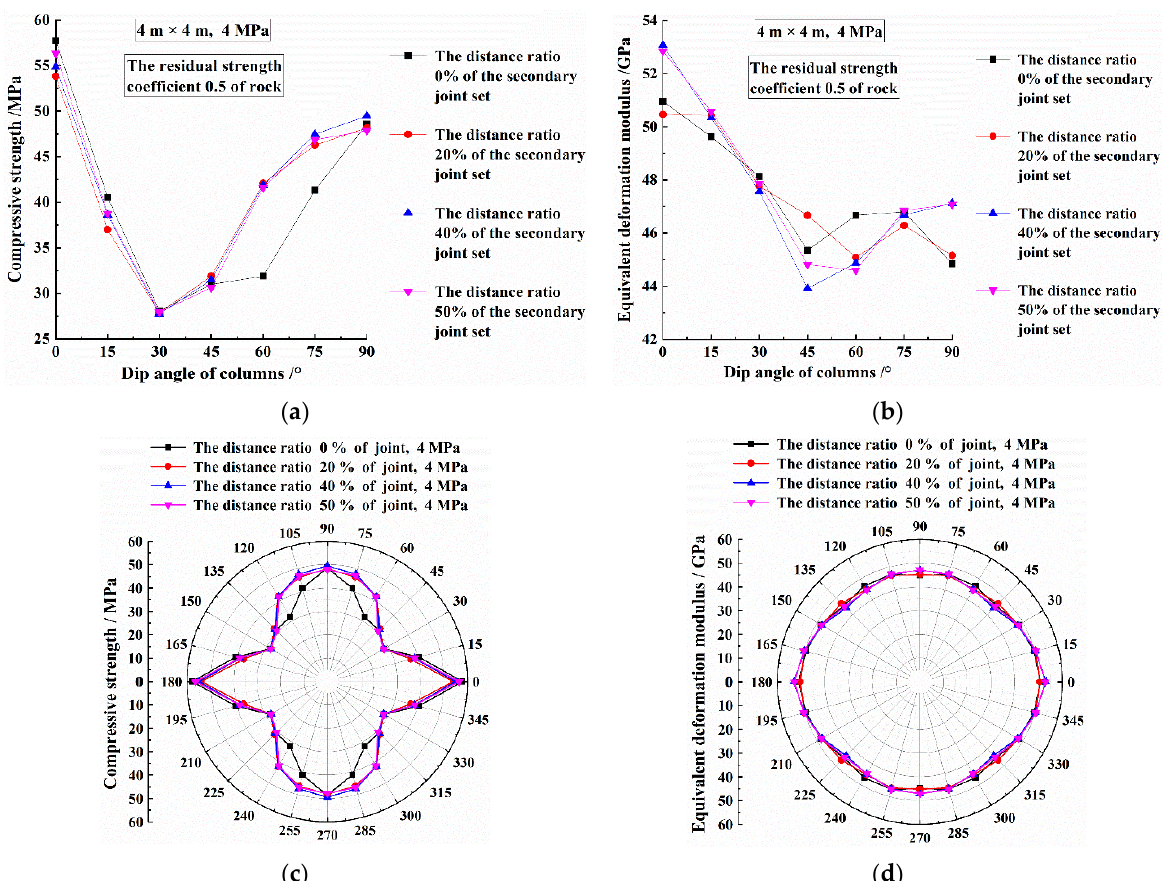
Figure 4. The CJBs with different joint distance ratios: ( a , c ) the compressive strength; ( b , d ) the equivalent deformation modulus.